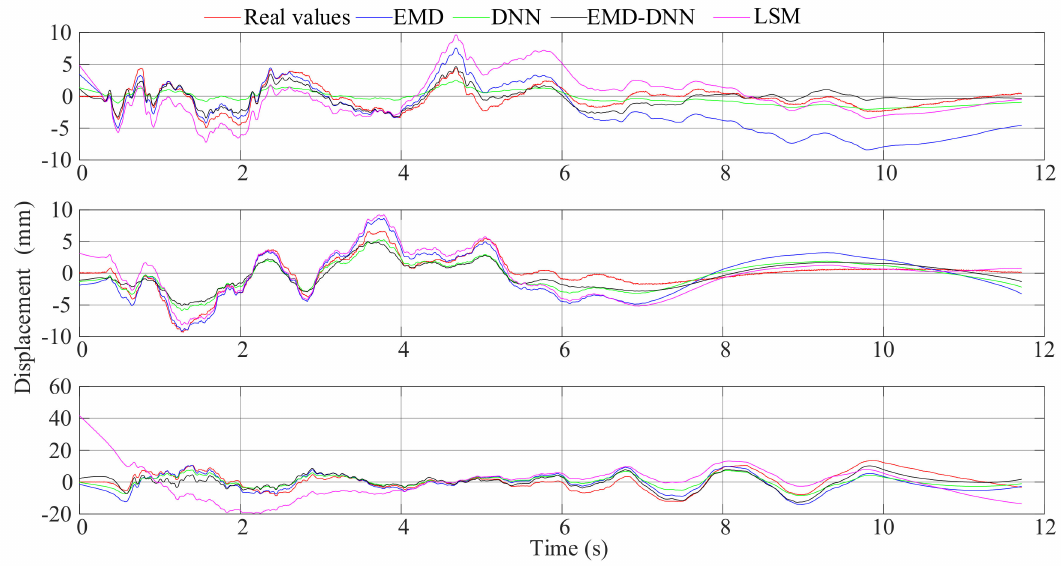
Figure 11. Comparison between baseline correction displacement curves of various methods and real displacement.